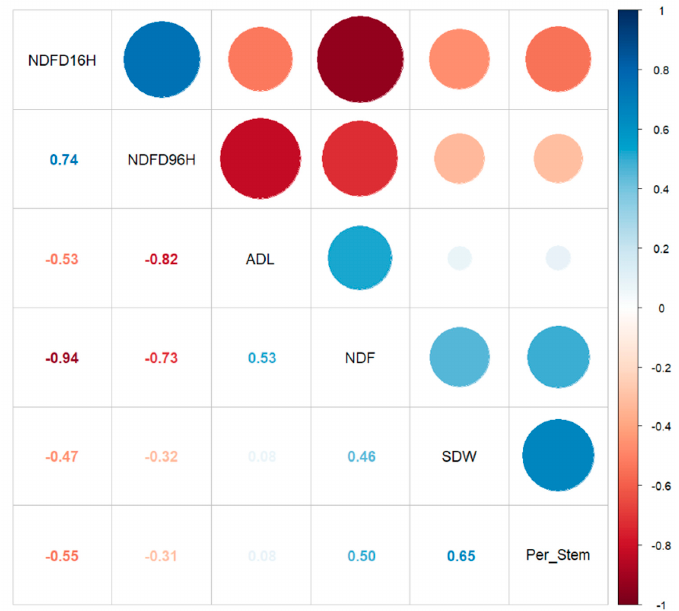
Figure 1. Pearson correlation among the digestibility and CW traits. Numeric values in the bottom lower left section are the correlation coefficients. Names along the diagonal are the variables. Size and color of the circles on the top right section show how strongly the variables are correlated.